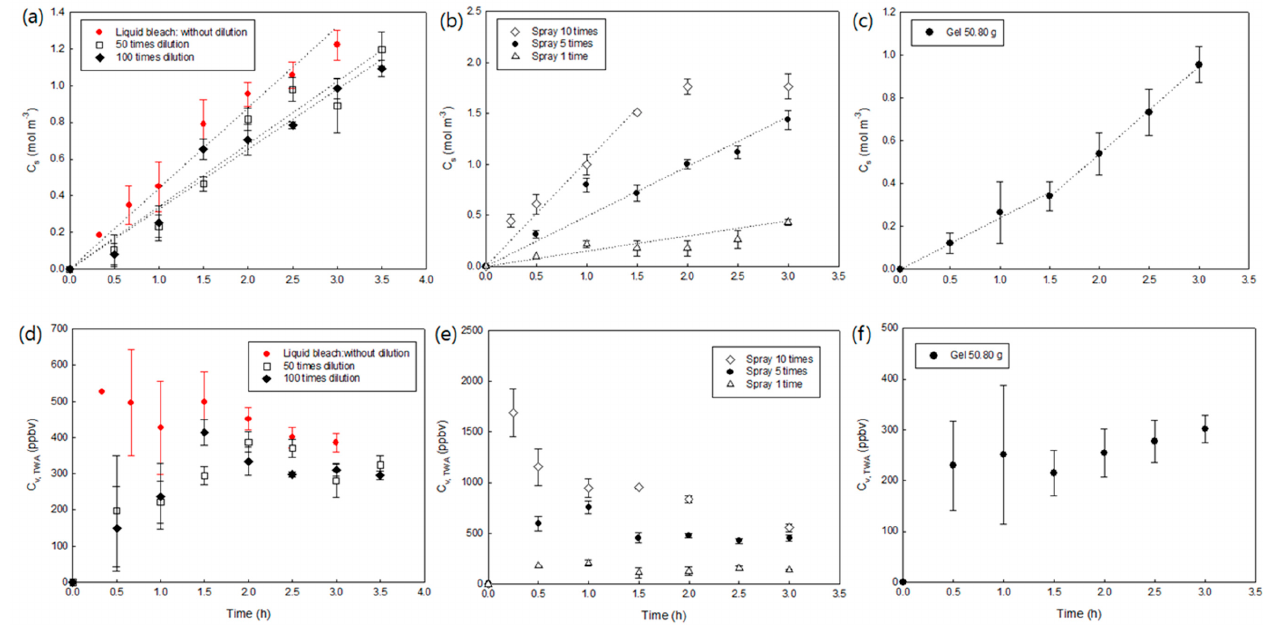
Figure 3. Effects of the type of chlorine-based disinfectants on C s (chlorine mass reacted with o -dianisidine per unit volume of passive samplers) and C v,TWA (time-weighted average chlorine concentration in air obtained from passive samplers). Figure 3 ( a ), ( b ), ( c ) shows how C s changes with time using liquid bleach, spray-type, and gel-type chlorinated disinfectants, respectively. Dotted lines in Figure 3 ( a ), ( b ), ( c ) are linear regressions applied in the range that C s increased linearly with time. Figure 3 ( d ), ( e ), and ( f ) shows C v,TWA using liquid bleach, spray-type, and gel-type chlorinated disinfectants, respectively. Error bars represent the standard deviations of triplicates.